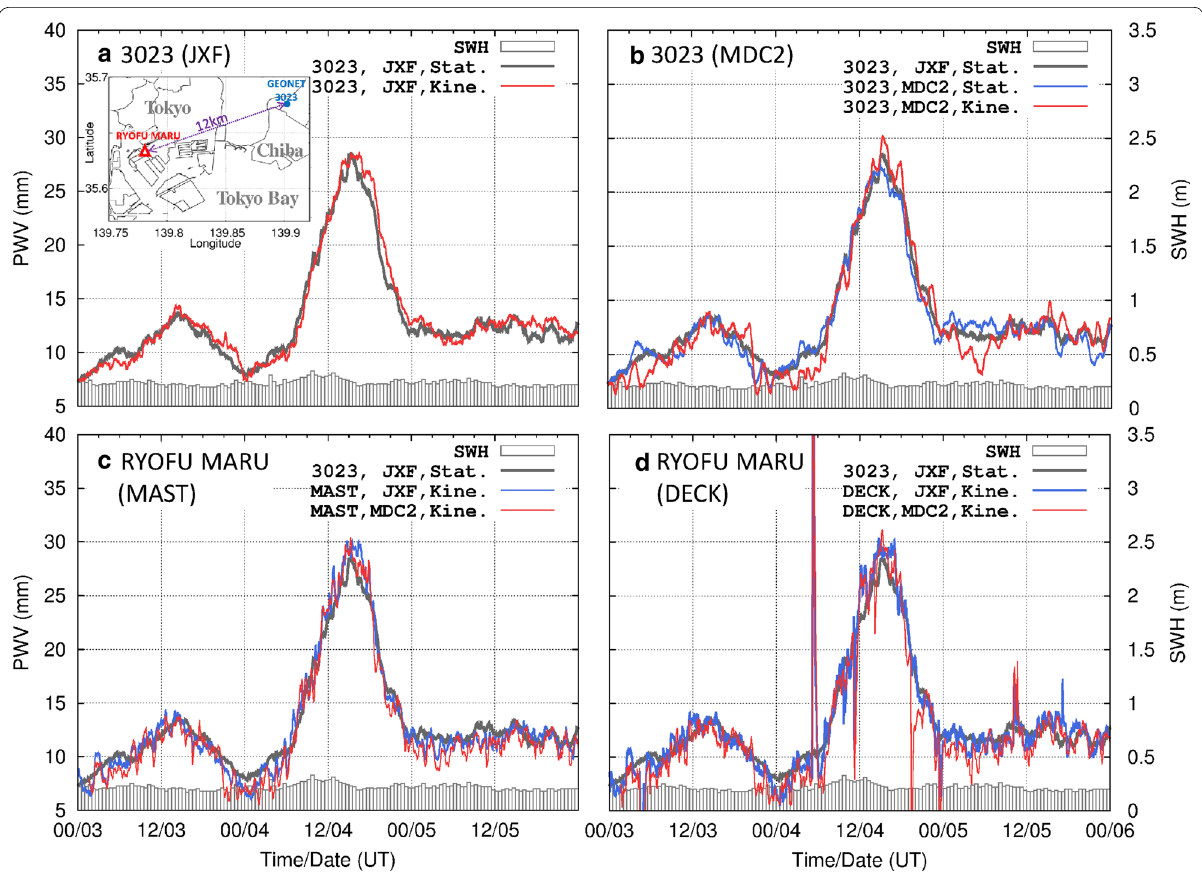
Fig. 2 Comparison of GNSS PWVs estimated at RYOFU MARU ( c , d ) and nearby GEONET station ( a , b ) for the 3 days from December 3, 2016, to December 5, 2016. The GEONET station 3023 (Chiba Ichikawa) locates approximately 12 km ENE from the RYOFU MARU. Results obtained using a final ephemeris (JXF) and a real-time ephemeris (MDC2) are compared. Both static and kinematic PPP procedures are conducted for GEONET station 3023, while only kinematic PPP is executed for RYOFU MARU stations. During this period, the RYOFU MARU was anchored at its home port (Daiba, Minato Ward, Tokyo). The gray boxes indicate the significant wave height observed by the RYOFU MARU (right